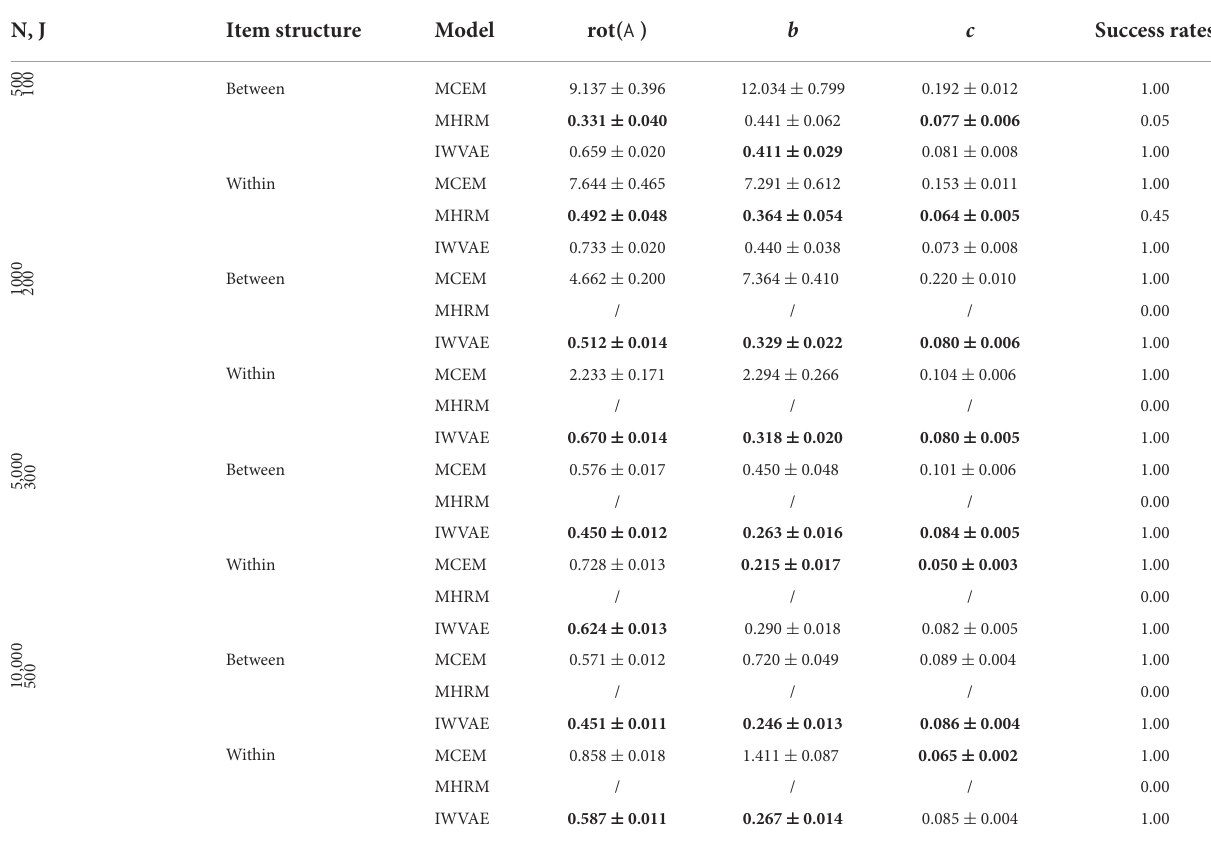
TABLE 8 Mean and SE of RMSE of M p estimate on M3PL models under double regime setting, best results are in bold.